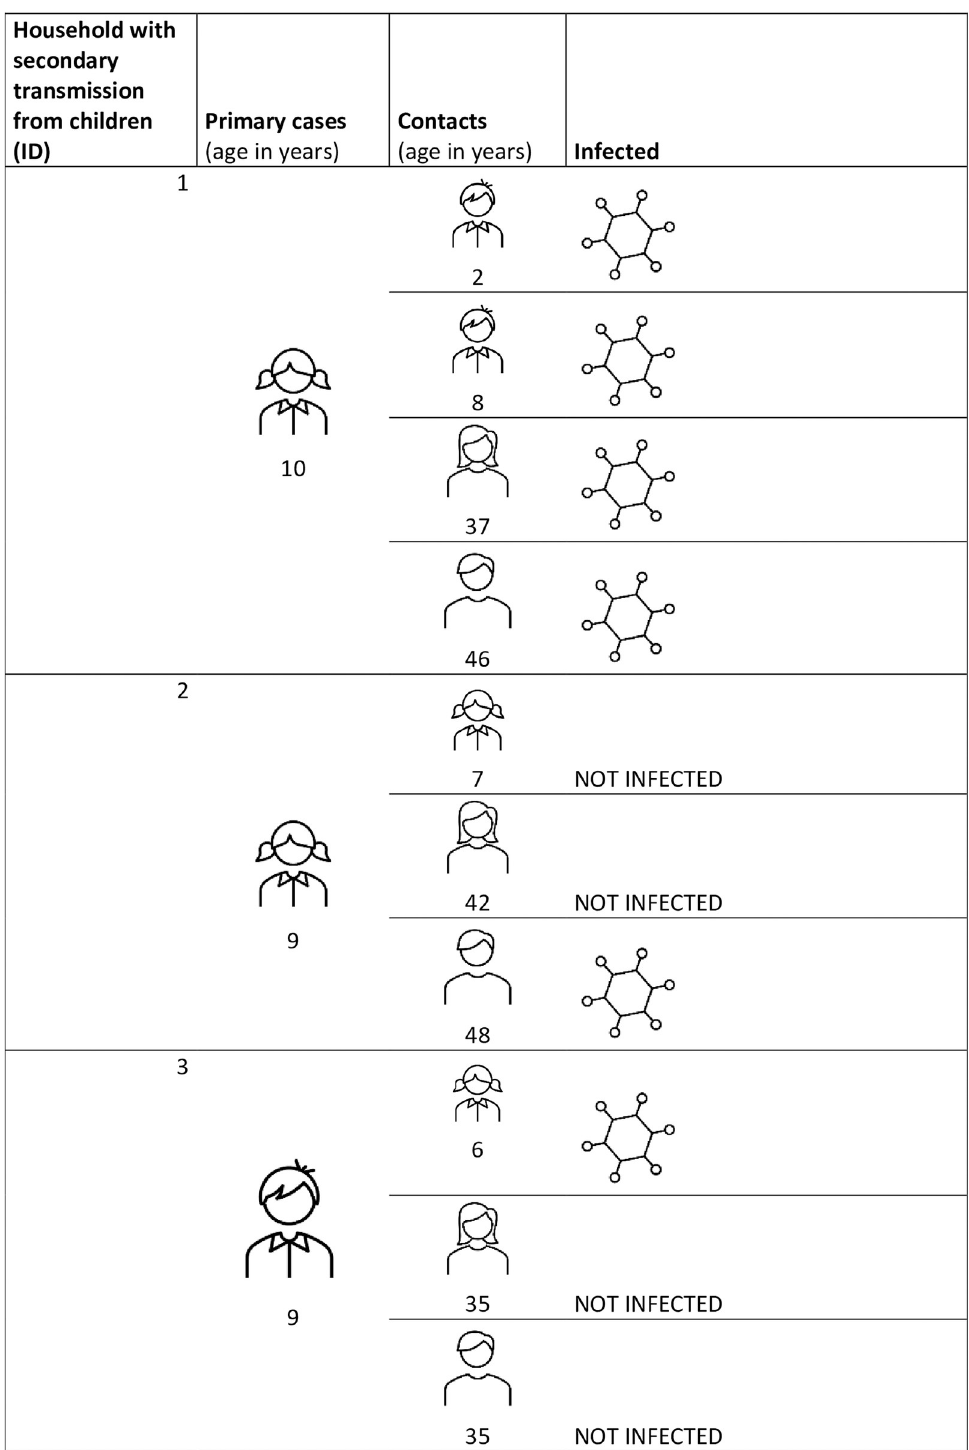
Fig 2. Description of the family clusters in which children infected other members of the household.